Question: Produce a descriptive caption suitable for publication.
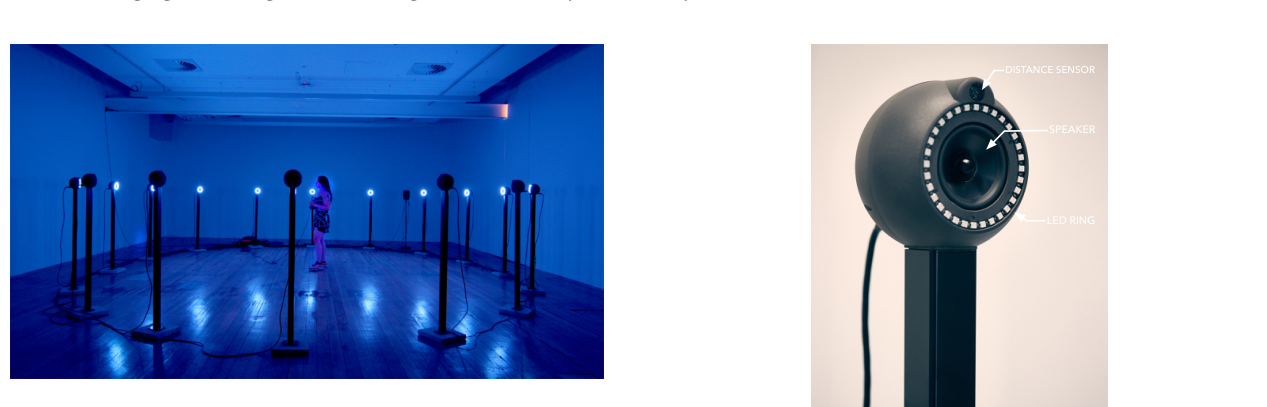
Answer: Excerpt from the live performance showing the uniformity in the hardware design of the virtual singers along with the position of the human performer.